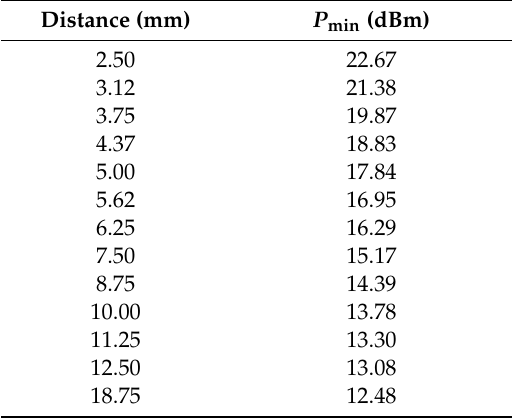
Table 8. Tag-to-meat distance factor effects. The mean values of the minimum power needed to activate the tag ( P min (dBm)) are reported for each tag-to-meat distance in the range 2.50–18.75 mm.